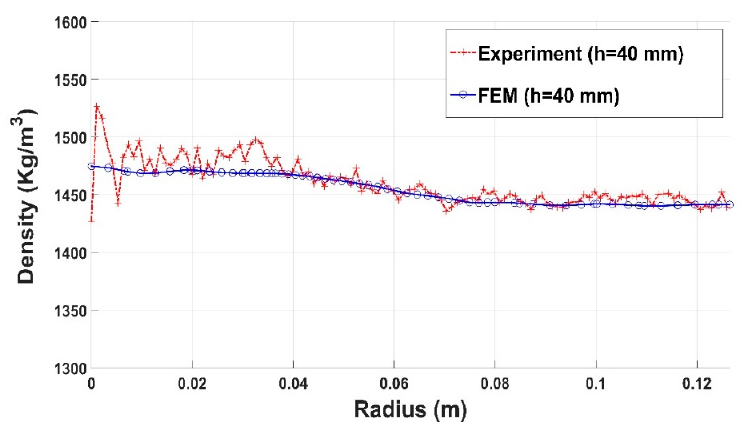
Figure 25. Layers used to compare numerical and experimental results for the stub-hole geometry.